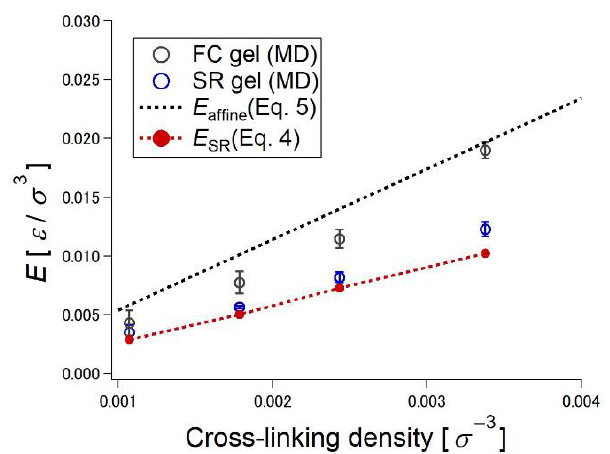
Figure 9. Cross-linking density dependence of Young’s modulus estimated by Affine network model (Equation (5)), three-chain model for SR networks (Equation (4)), and MD simulations of FC and SR gels. Reprinted from [27] with permission from American Chemical Society.